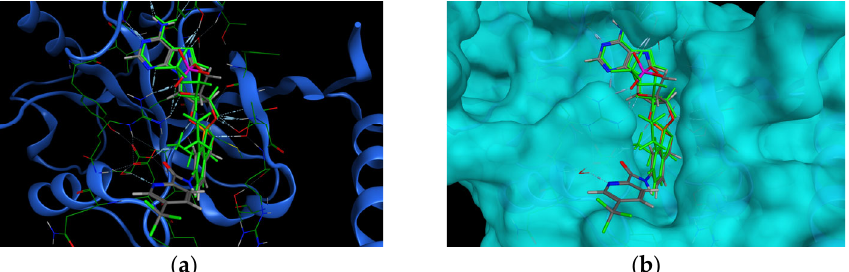
Figure 4. ( a ) The pose of one of the template ‐ docked compounds, compound 11 (grey) into mtbLeuRS (PDB ID: 5AGR, the original co ‐ crystallized ligand in green) interacting with D447. ( b ) The same pose with the calculated surface.